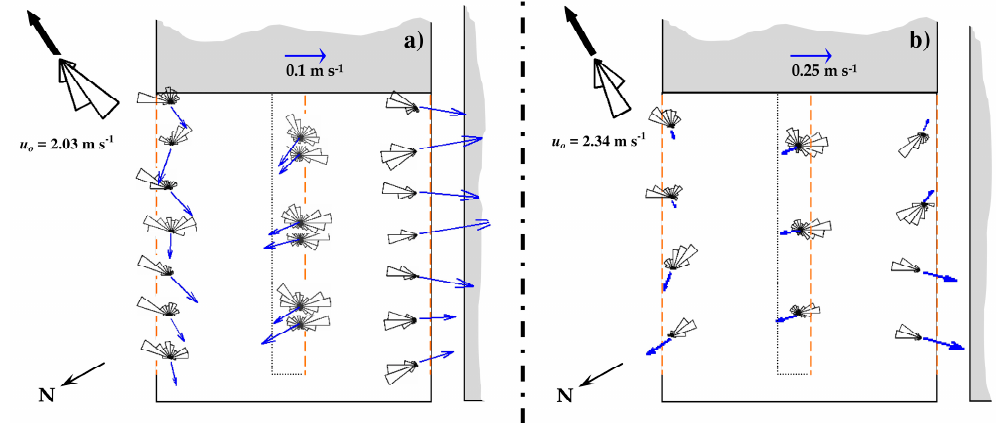
Figure 3. Polar histograms of the horizontal angle and projection of the air velocity (plane XY) at the side vents (middle of the vent) and at the roof vent in the western sector of the experimental greenhouse in conditions of light southwest wind (SW). Tests 4 on 07 / 05 / 2009 ( a ) and 6 on 23 / 04 / 2009 ( b ).